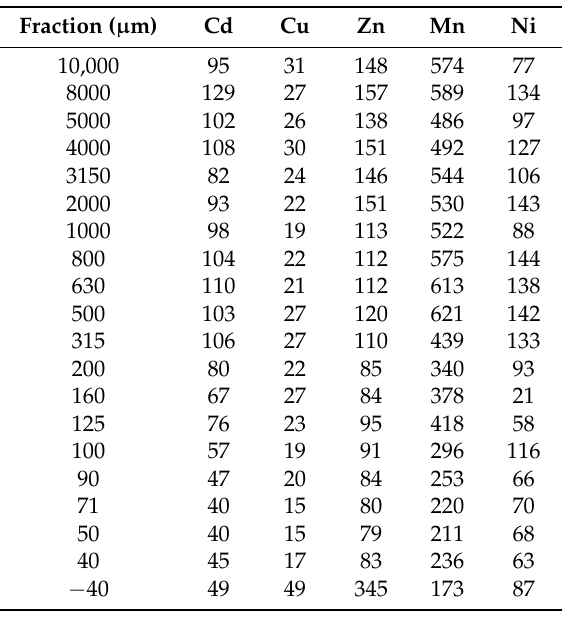
Table 4. Concentrations (mg/kg) of metallic trace elements in different size fractions of the studied raw